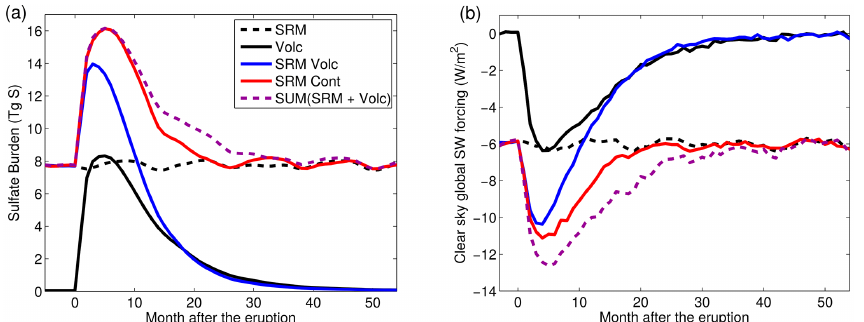
Figure 2. (a) Stratospheric sulfate burden and (b) global mean clear-sky shortwave radiative forcing at the surface in the different scenarios. In addition, the dashed purple line represents the sum of SRM and Volc runs, and is shown for